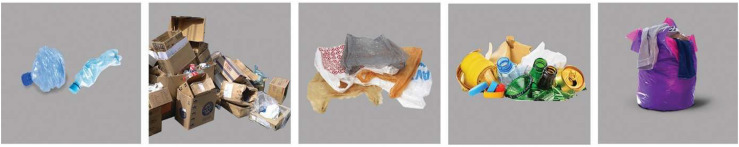
Samples of critical pictures used in Experiment 2.